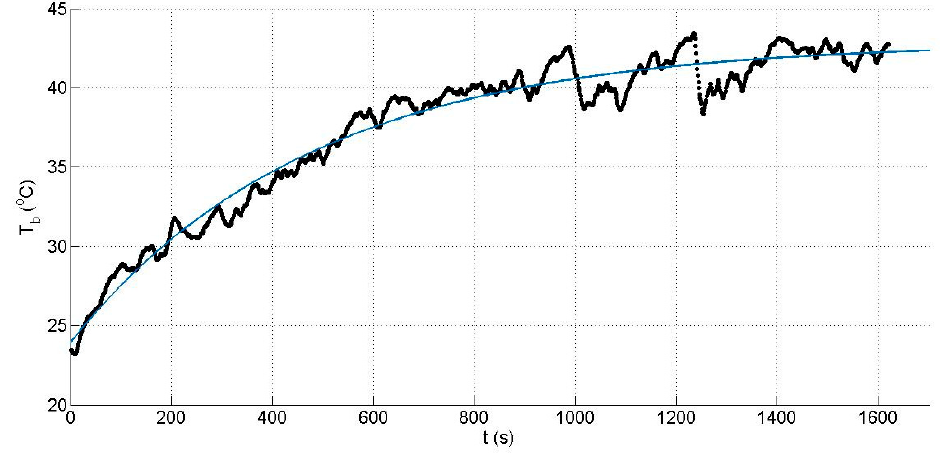
Figure 5. T b (t) profile for a c-Si Bioenergy 195W PV module in field conditions.